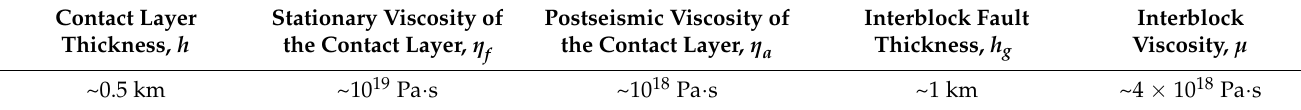
Table 2. Typical values for parameters of viscous elements of the model according to